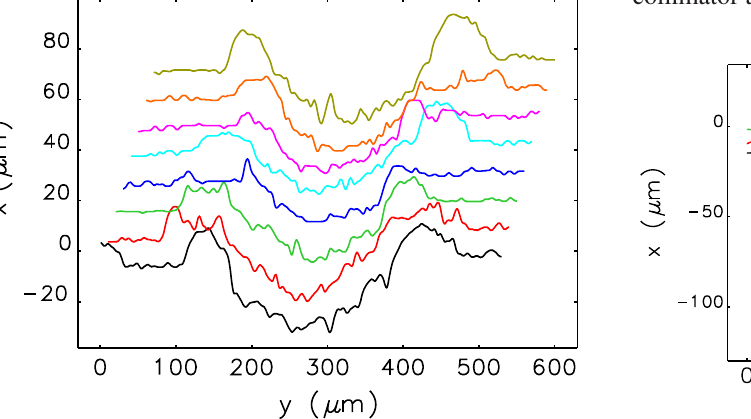
FIG. 29. Surface profiles from the SN08 strike zone of Fig. 28 showing relatively large variation in depth along the trench. Separation between the profiles is 300 μ m starting from z ¼ 0